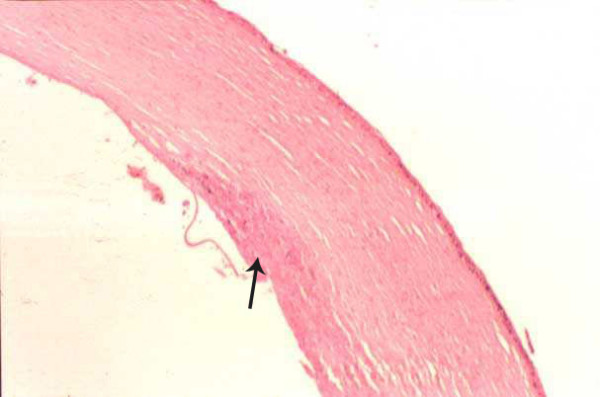
Section showing intact epithelium, with deep stromal infiltrates (arrow) (Hematoxylin and Eosin stain, ×20).